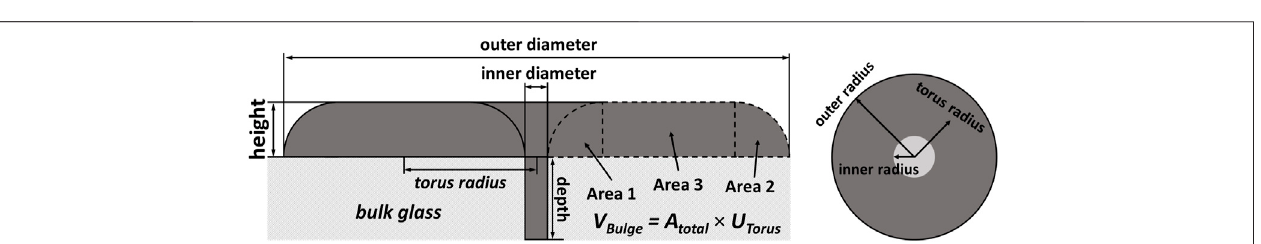
FIGURE10| Schematicdrawingofthecrosssectionofasurfacemodi fi cationandpartsofthebulk(left)andfromthetopview(right).Withtheresultsobtainedfrom SEM and LSM measurements all mentioned spatial characteristics can be derived and the area and volume can be calculated according to Eqs 2 – 5 . With the assumptionofanideal,opencylinderinthecenter,theequivalentvoidchannelvolumeandopenchanneldepthcanbeobtained,andestimationoftheremainingmaterial can be concluded.